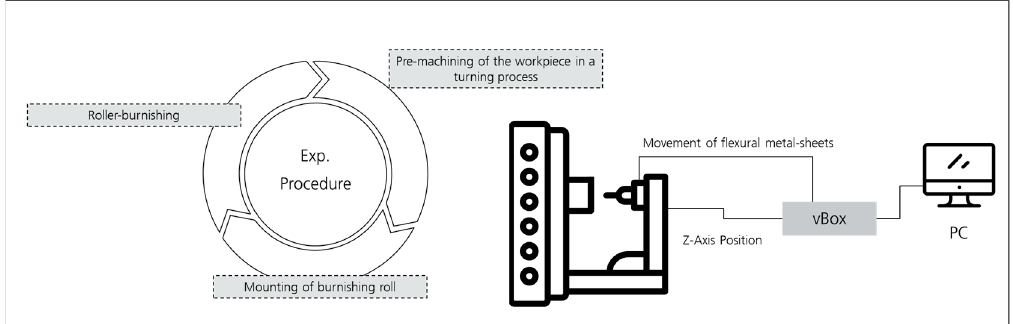
Figure 6. Left: Schematic representing the steps of one experiment, consisting of 1, Pre-machining of the workpiece in a turning process; 2, Mounting of the burnishing roll in the burnishing tool; and 3, Finishing operation in roller-burnishing. Right: Schematic of signal acquisition, with the tool deflection and z-axis position acquired from the used machine tool. The data was collected and synchronized by the Fraunhofer vBox and sent to a PC for subsequent processing. Source: own-elaboration.